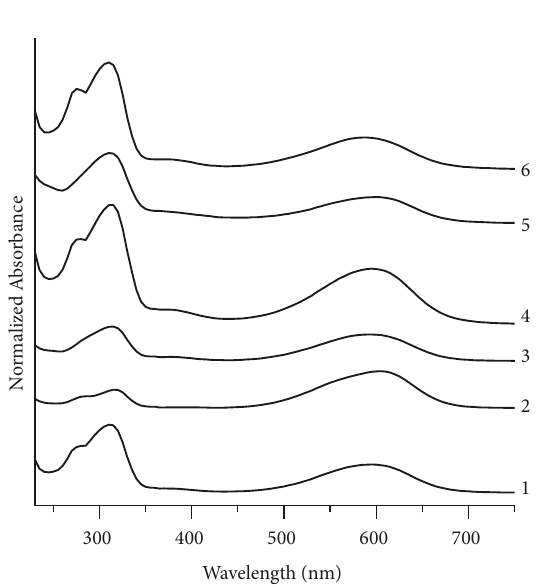
Figure 1: Normalized UV/Visible absorption spectra for blue fountain pen inks. 1, 2, 3, 4, 5, and 6 represent samples no. BL1, BL2, BL3, BL4, BL5, and BL6,